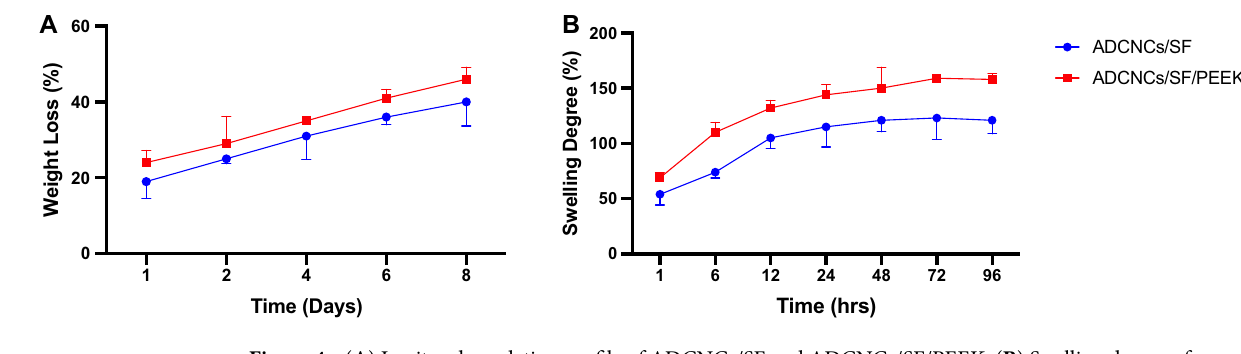
Figure 4. ( A ) In vitro degradation profile of ADCNCs/SF and ADCNCs/SF/PEEK. ( B ) Swelling degree of ADCNCs/SF and ADCNCs/SF/PEEK hydrogels. Data are expressed as mean ± standard deviation ( n =